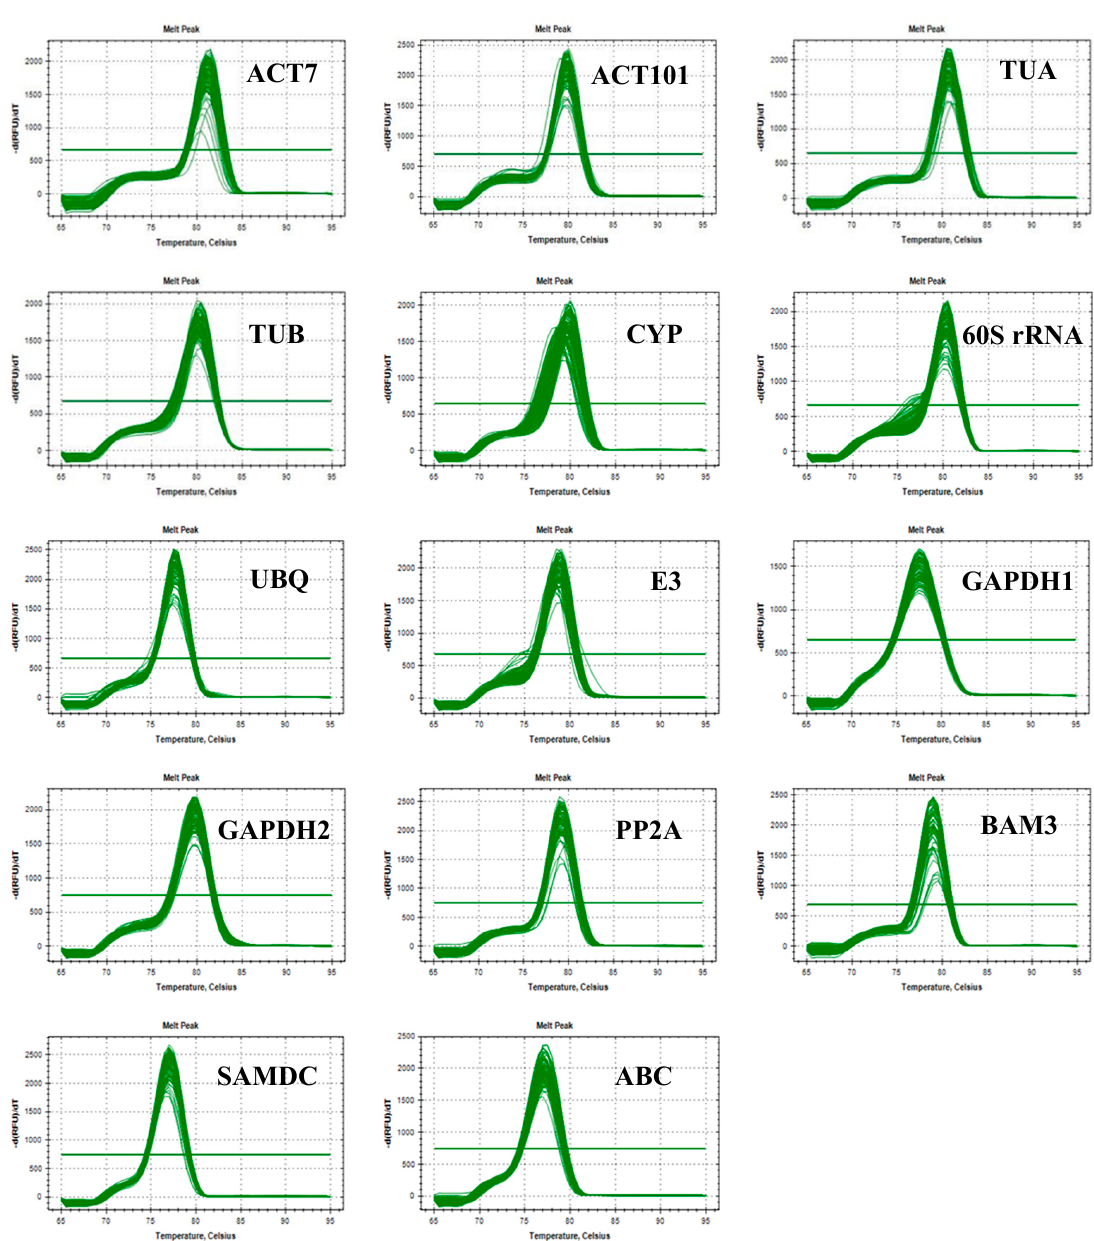
Figure 2. Melting curves for 14 reference genes (the horizontal lines represent baseline thresholds). The expression levels of 14 candidate reference genes in all white clover samples are shown in